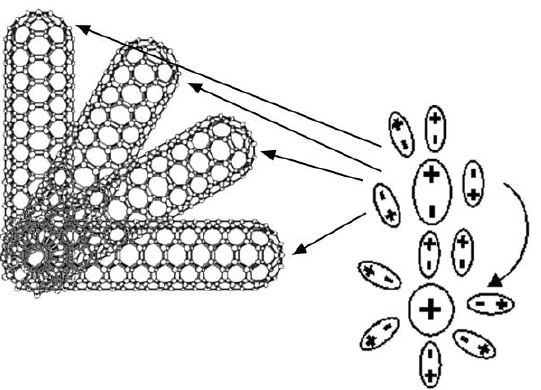
Figure 4. Possible consideration of the orientation of a CNTs end according several dipoles.